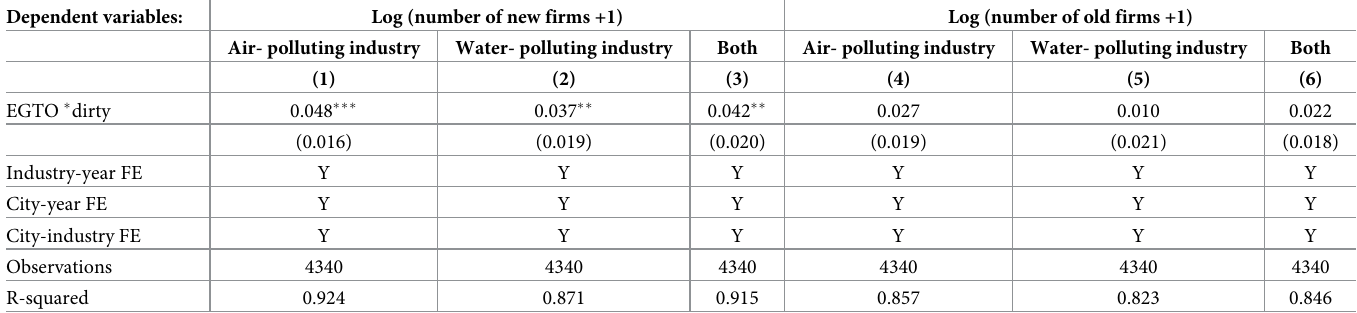
Table 5. Effect of EGTO on the number of new and old enterprises. Dependent variables: